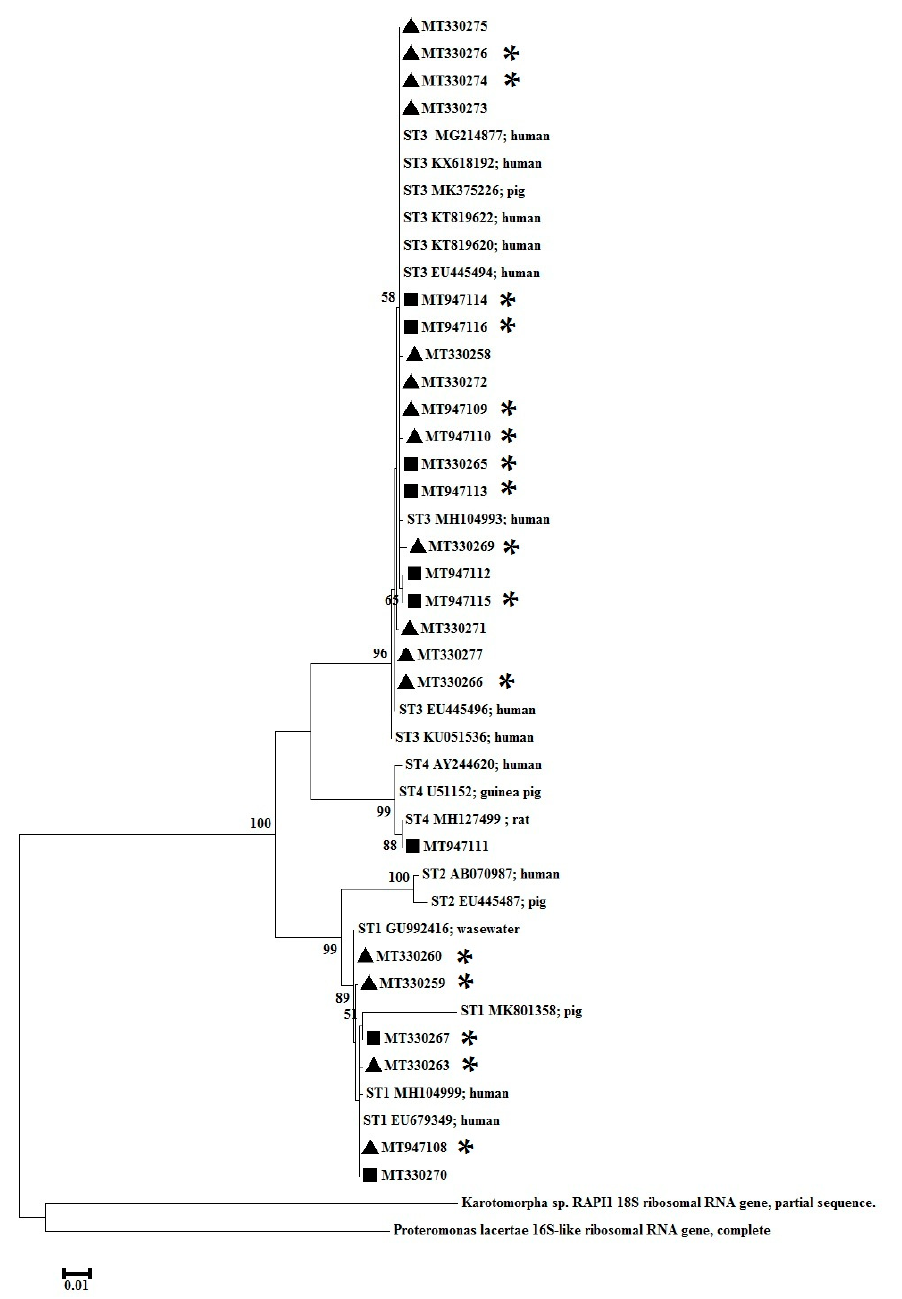
Figure 1. Maximum likelihood analysis of the Blastocystis SSU rRNA (small subunit ribosomal RNA) gene based on the general time reversible model. The outgroup sequences were Proteromonas lacertae (U37108) and Karotomorpha sp. (DQ431242). Symbol (cid:78) —Diabetes DM, (cid:4) —Non-DM and * —Presence of animals in the household.